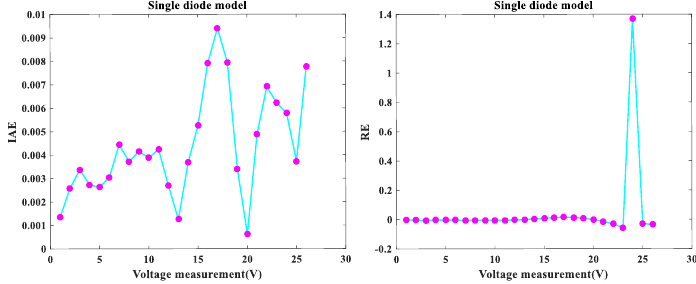
Figure 2. MLCPA for SDM I-V characteristics and P-V characteristics.